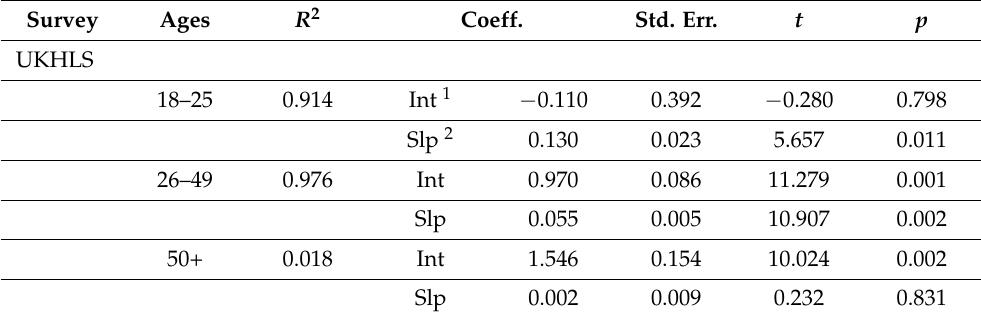
Table 2. Regression analyses (coefficients, standard errors, t , and p values) of the last five waves of the UK Household Longitudinal Study (UKHLS) before 2020.